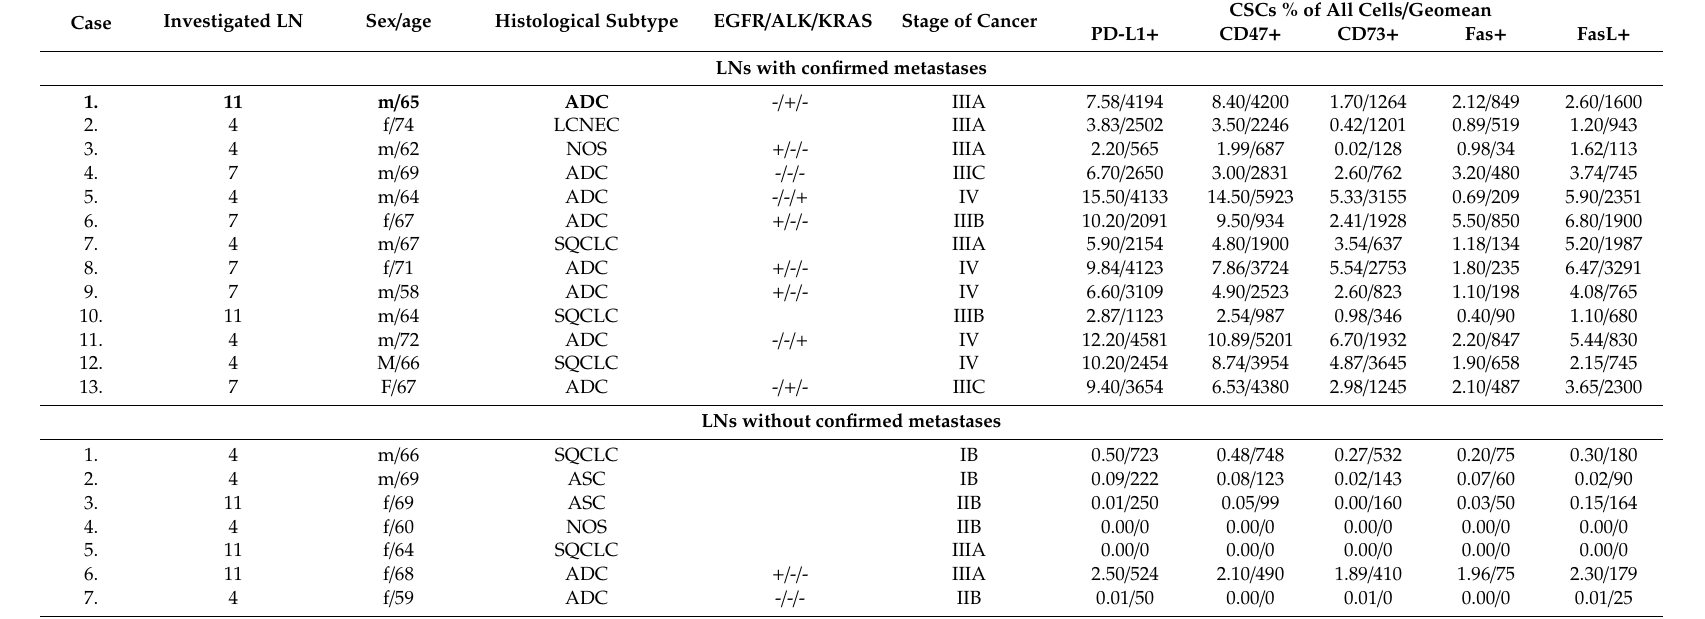
Table A1. The characteristics of the investigated group, the cell frequencies, and the GMF intensity of PD-L1, CD47, CD73, Fas, and FasL on CSCs. Data are expressed as median values (p25–p75). m, male; f, female; ADC, adenocarcinoma; SQCLC, squamous cell carcinoma; ASC, adenosquamous carcinoma; LCNEC, large cell neuroendocrine carcinoma; NOS, not otherwise